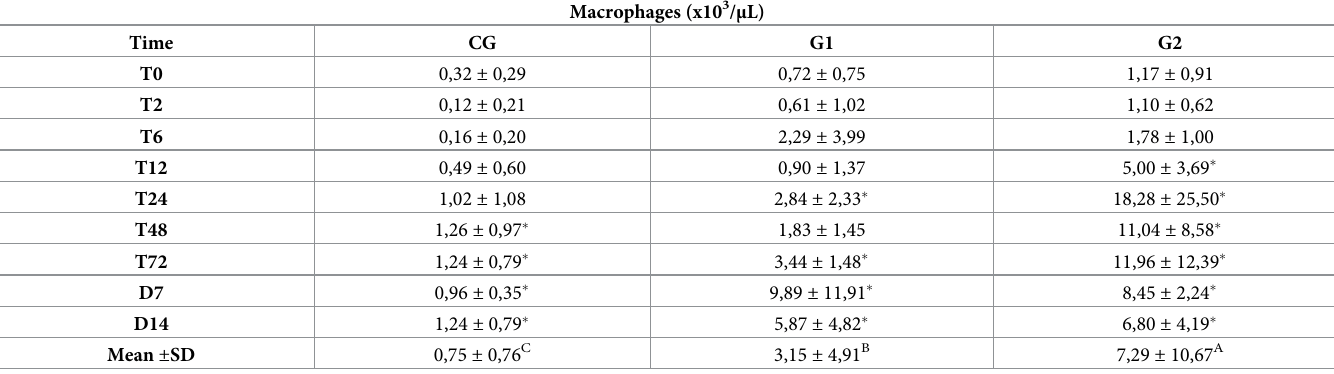
Table 3. Mean and standard deviation (SD) of macrophages in the peritoneal fluid of healthy horses (CG) and horses submitted to cecal trocarization with a cecal needle (G1) or a cattle trocar (G2).